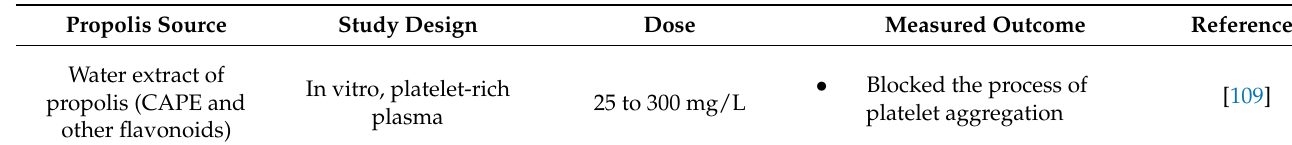
Table 7. Summary of clinical trials which experimented with the activity of propolis and its con- stituents against